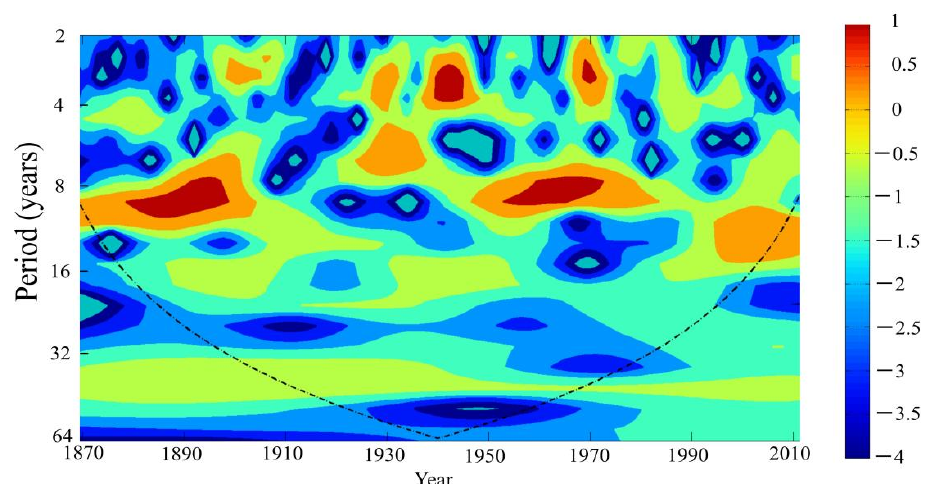
Figure 10. Wavelet power spectrum analysis plot for the Larix chinensis tree ‐ ring width RES ‐ chro ‐ nology ‐ based annual maximum NDVI